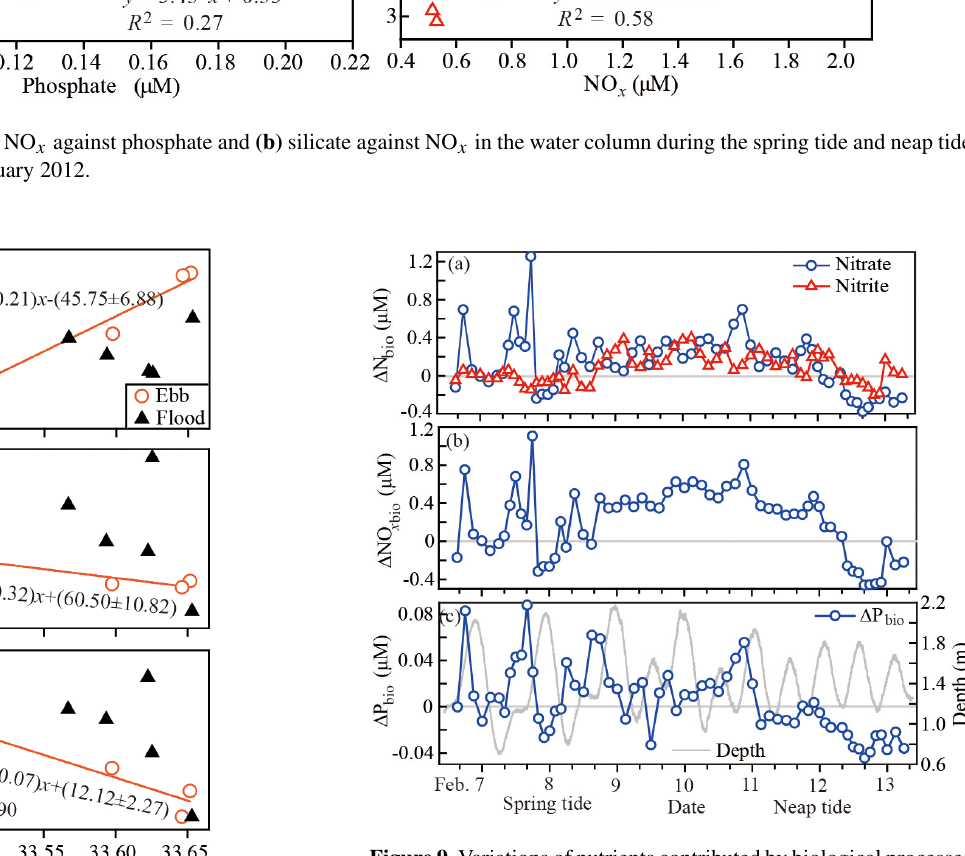
Figure 9. Variations of nutrients contributed by biological processes in a spring–neap tide during 6–13 February 2012 at the coastal reef station CT. (a) Nitrite and nitrate, (b) NO x , and (c) phosphate (P). Water depth was reported in Wang et al.